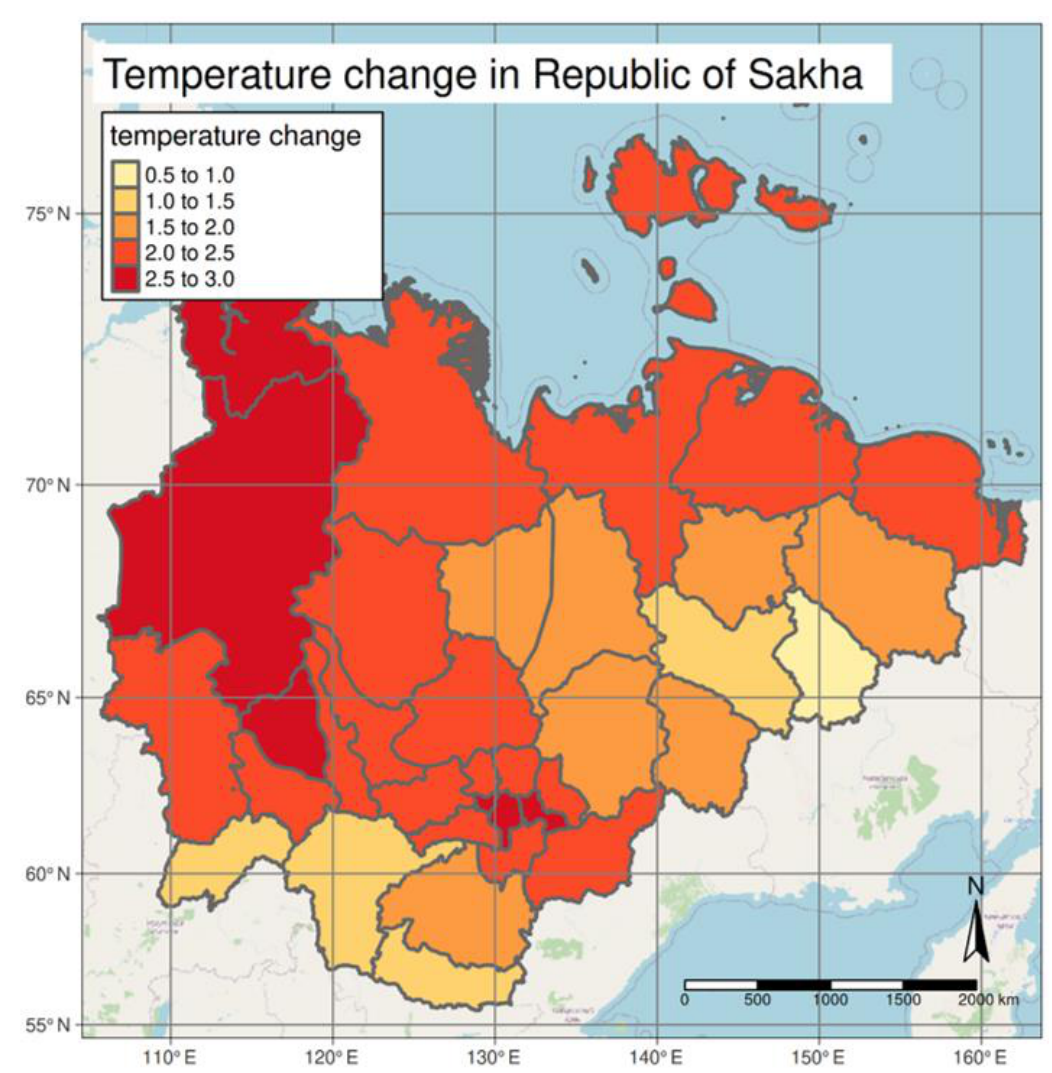
Figure 3. The difference in the average temperature ( ◦ C) between 1981–1982 and 2017–2018, for districts in the Republic of Sakha. Temperature was data obtained from ERA5 Climate Reanalysis. Darker red denotes a larger temperature increase.